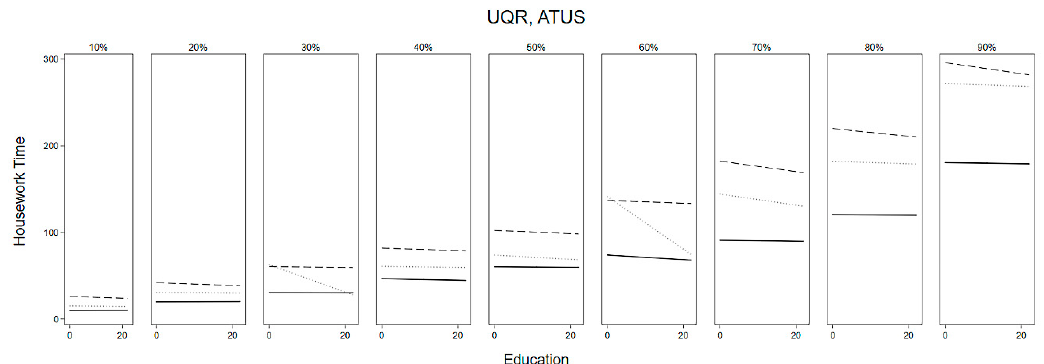
Figure 2. UQR Predicted Housework Time by Education over Deciles of Housework Participation, US.